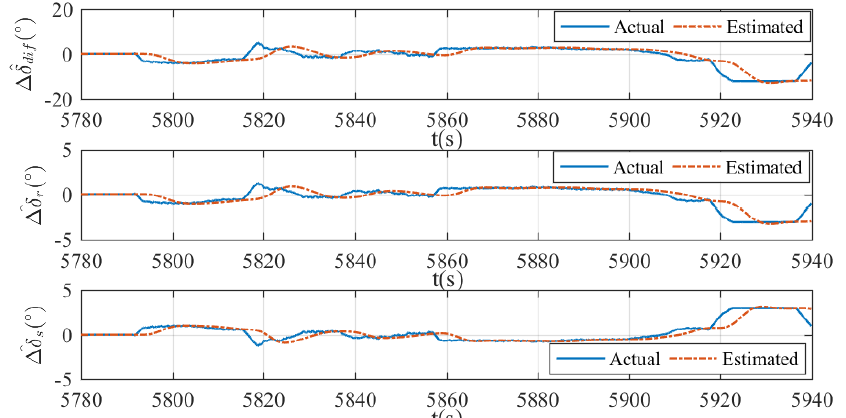
Figure 20. Estimation of ∆ u in case 2. The estimated di ff erential angle (top), the estimated virtual vertical rudder angle (middle), and the estimated virtual horizontal rudder angle (bottom).